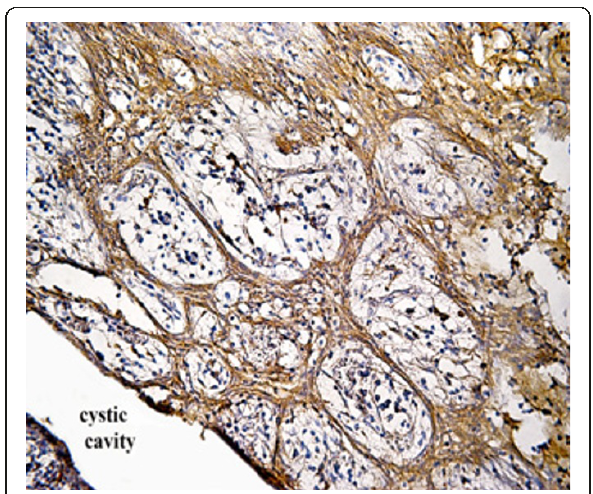
Figure 6 Photomicrograph of intraluminal plexiform variant of UCA showing cytoplasmic immunopositivity in tumor cells forming strands (Anti-OPN. Original magnification x40) .